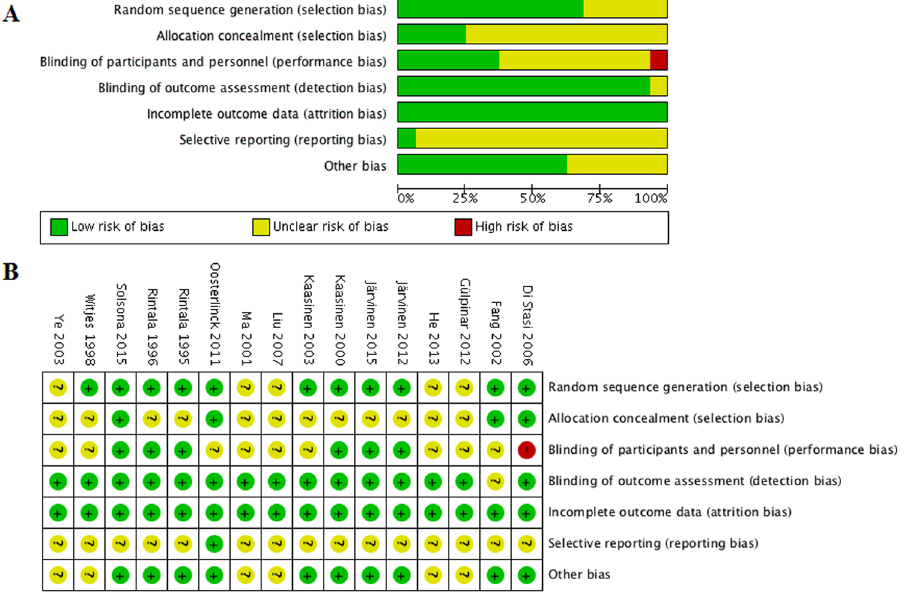
Figure 2. Assessment of bias risk for included RCTs. ( A ) Methodological quality graph: authors’ judgments about each methodological quality item presented as percentages across all included studies; ( B ) Methodological quality summary: authors’ judgments about each methodological quality item for each included study, “ + ” low risk of bias; “?” unclear risk of bias; “ − ” high risk of